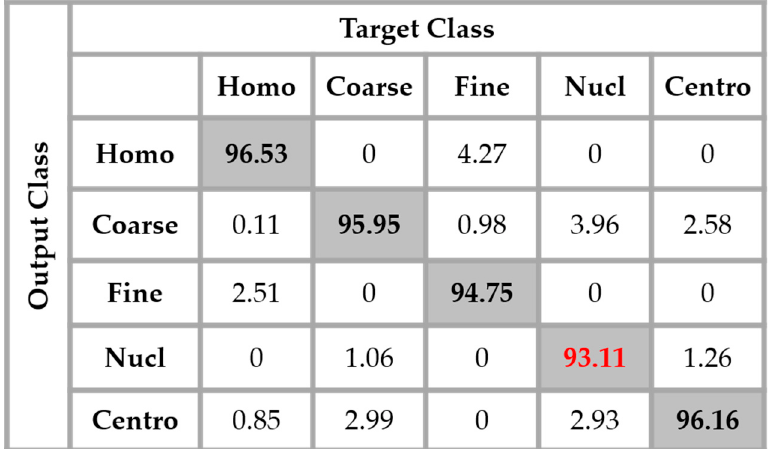
Figure 14. Confusion matrix of the results over the testing set by using the proposed dynamic learning without data augmentation. The total accuracy is 95.3%.